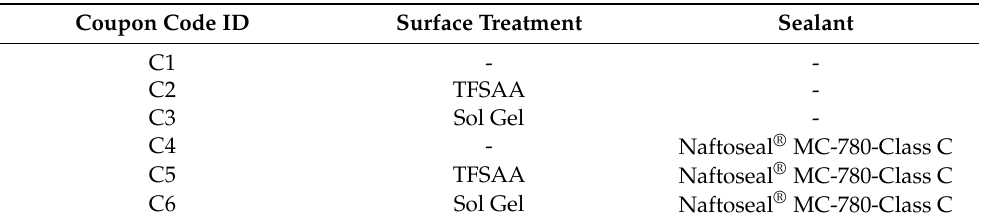
Table 2. Friction stir welded coupon identification with the applied surface treatments and sealant.